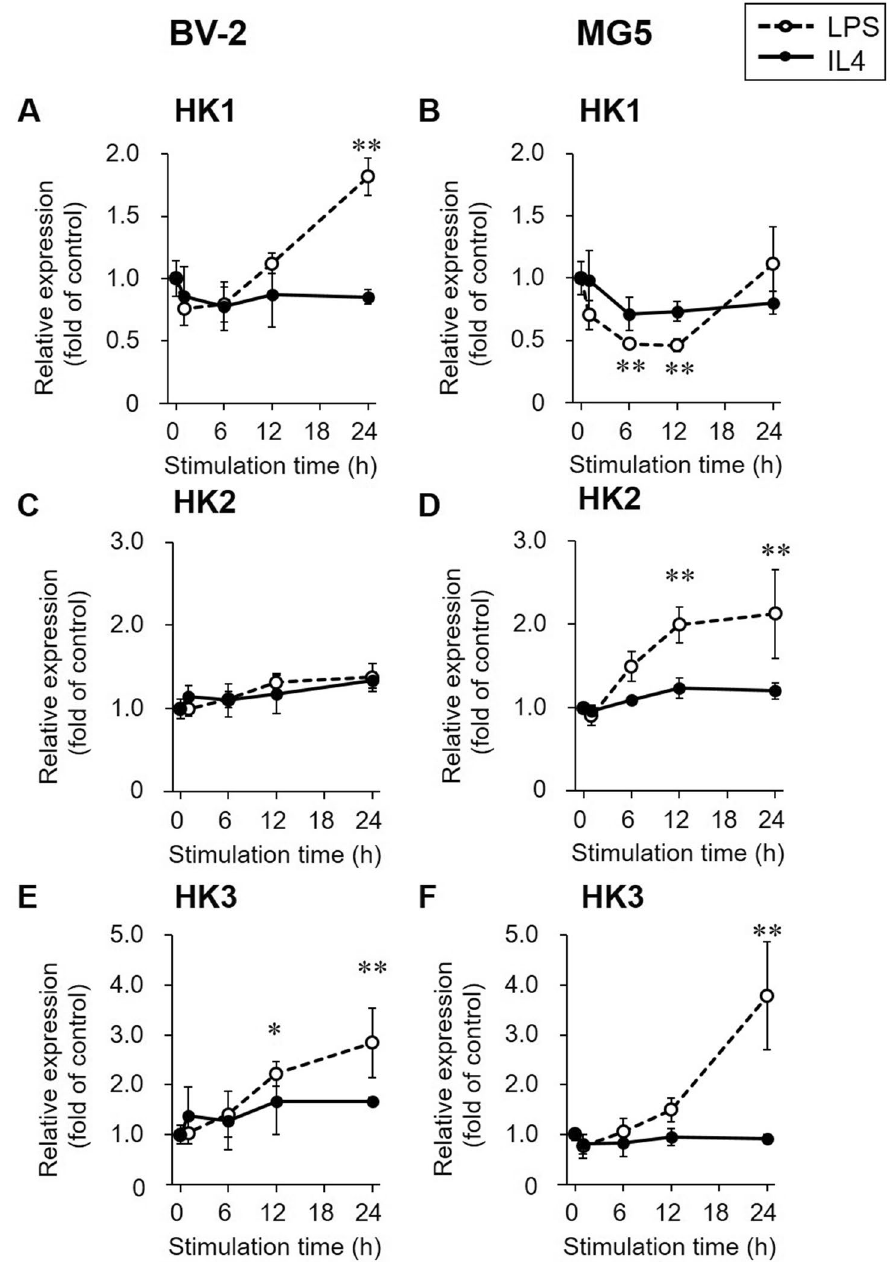
Figure 3. Gene expression of hexokinases (HKs). Relative gene expression levels of HK1 ( A and B ), HK2 ( C and D ), and HK3 ( E and F ) were determined by RT-PCR in LPS (1000 ng/mL, open circle and dashed line)- or IL4 (60 ng/mL, closed circle and solid line)-stimulated BV-2 and MG5 cells. The results are presented as the fold change relative to the control group (0 h stimulation) and the means ± SDs of three samples. Statistical differences were analyzed by ANOVA followed by Dunnett’s multiple comparison test; * p < 0.05, ** p < 0.01 compared with the